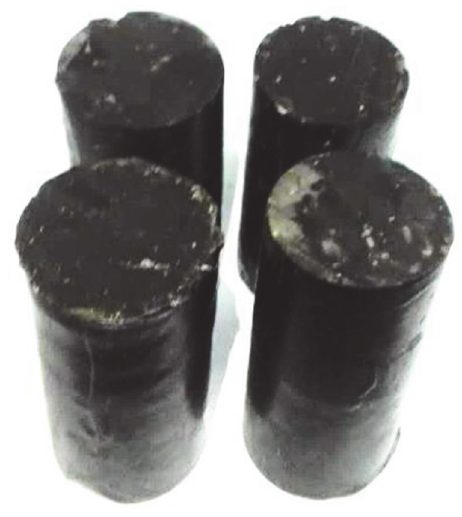
Figure 1: Lignite specimen for the permeability